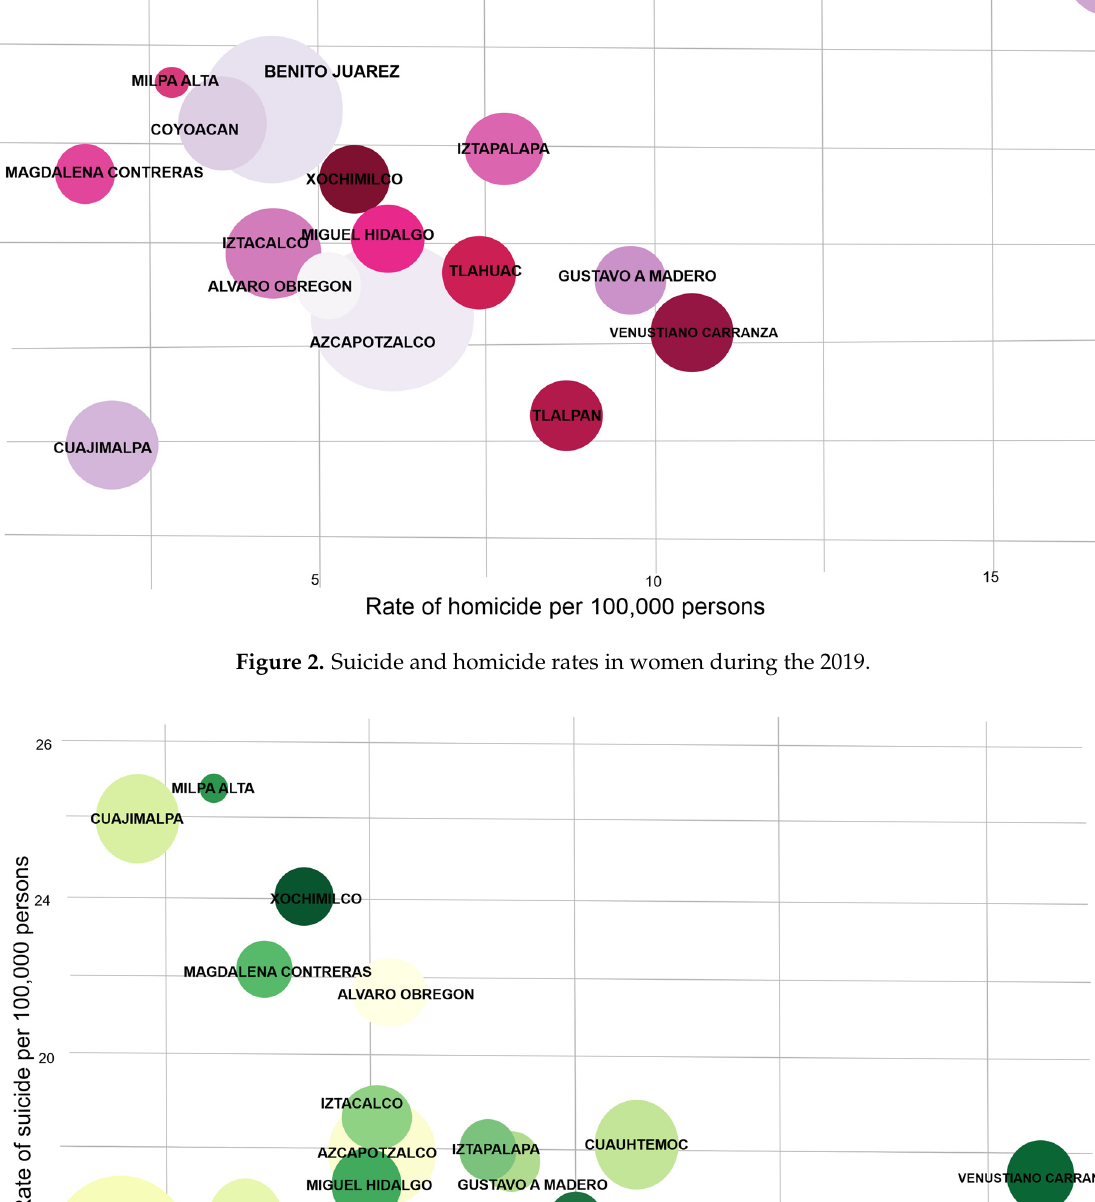
Figure 3. Suicide and homicide rates in men during the 2019.